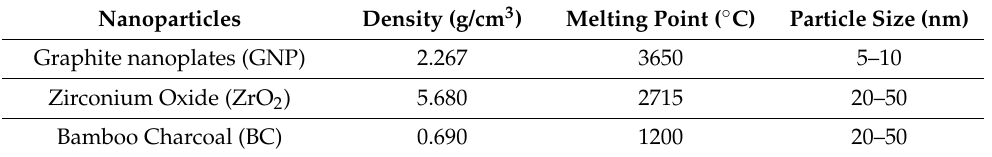
Table 2. Details of nanoparticles reinforced in CO-based flexible polyurethane